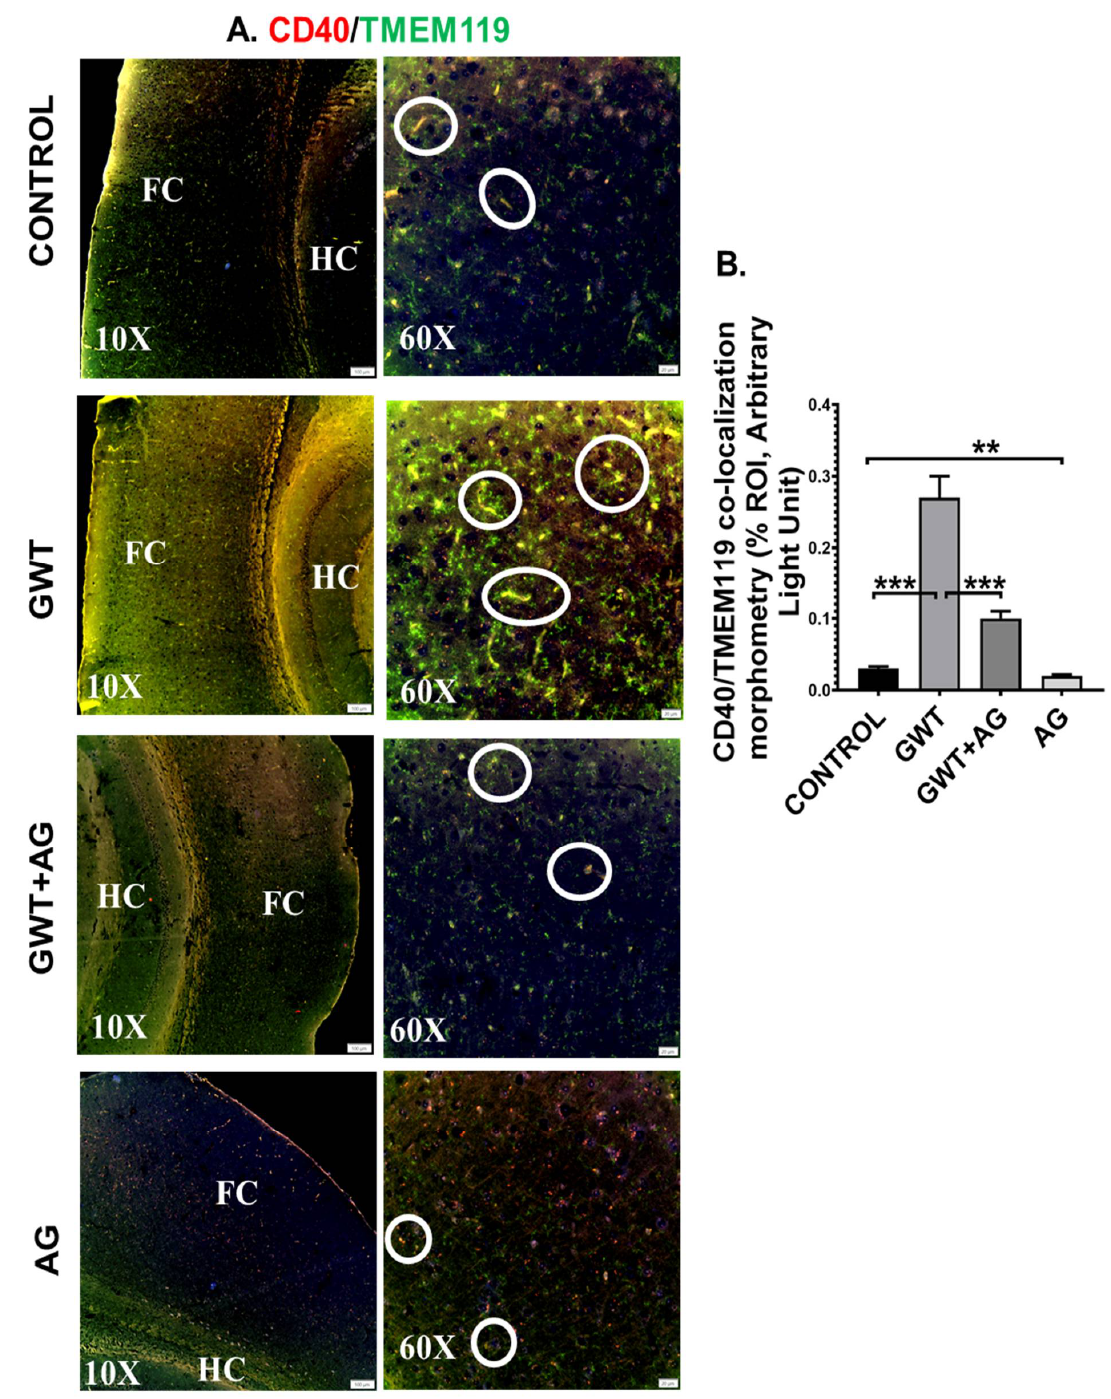
Figure 7. Microglial activation, caused by GW chemical treatment, is decreased by AG administration. Representative immunofluorescence images depicting ( A ) CD40 (red) and TMEM119 (green) co-localization events in the brain sections, counterstained with DAPI (blue) of CONTROL, GWT, GWT+AG, and AG mice groups. Images were taken at 10 × and 60 × magnification. Co-localization was represented by the yellow dots and marked by white circles. The Hippocampus region is marked as HC, whereas the frontal cortex is marked as FC. ( B ) Morphometric analysis (calculated as %ROI) of CD40 and TMEM119 co-localization events. Y -axis represents % positive immunoreactive area (% ROI) ( n = 3; mean value taken from three separate microscopic fields) (** p < 0.01, *** p < 0.001). Data were represented as mean ± SEM and statistical significance was tested using unpaired t -test between the groups (* p < 0.05, ** p < 0.01, *** p < 0.001), followed by Bonferroni Dunn Post hoc